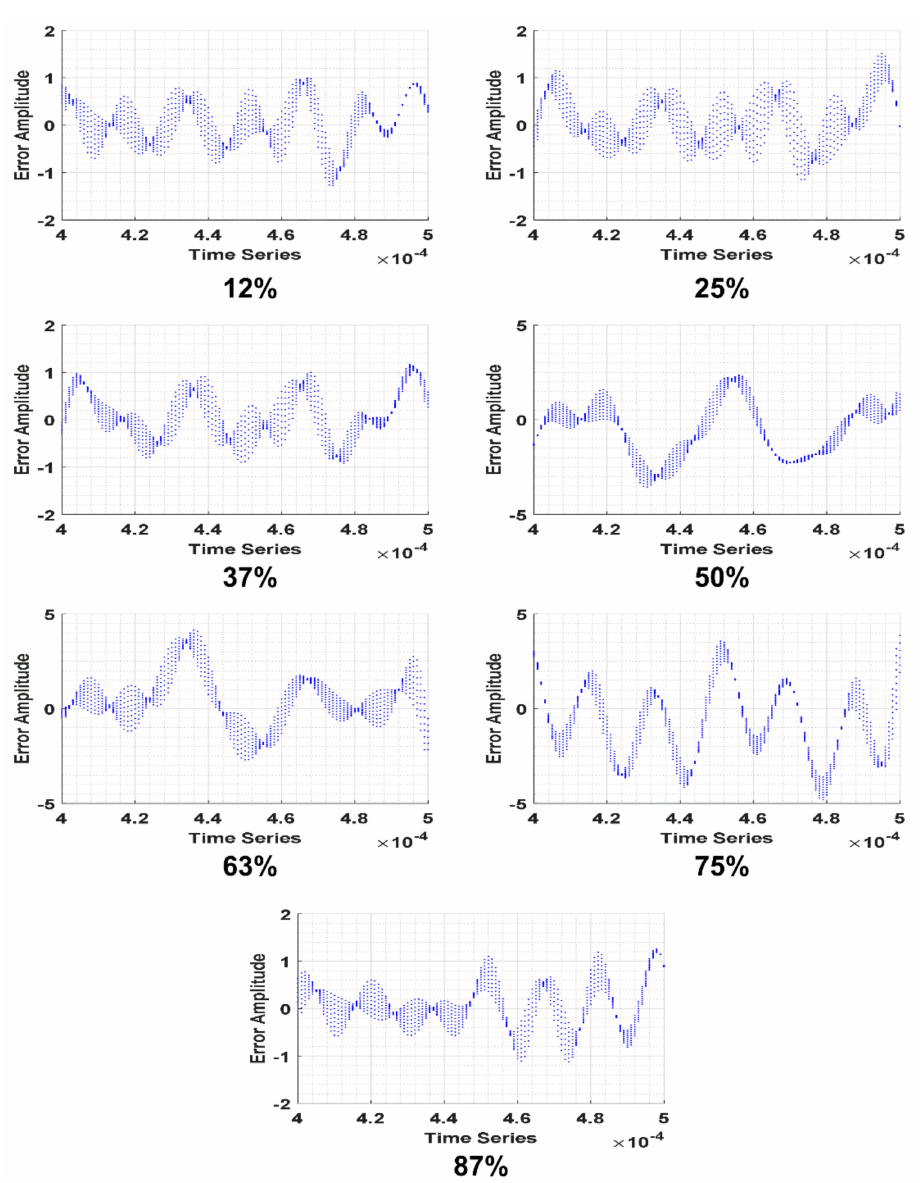
Figure 14. Residual error of the actual signal and model results for cracks along axis